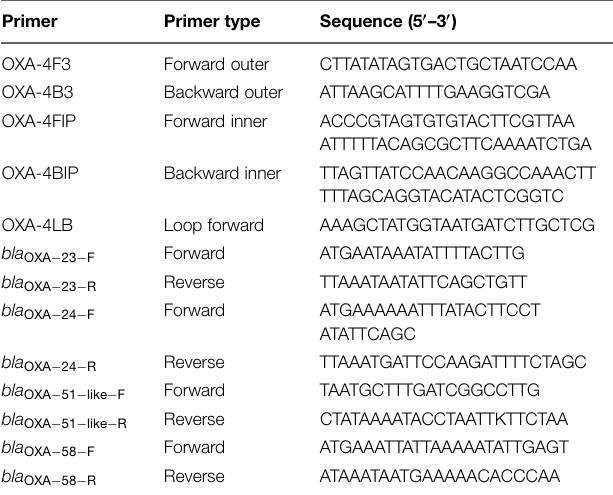
TABLE 2 | Sequence of primers used for specific amplification of bla OXA − 51 − like and the OXA carbapenemases PCR detection.